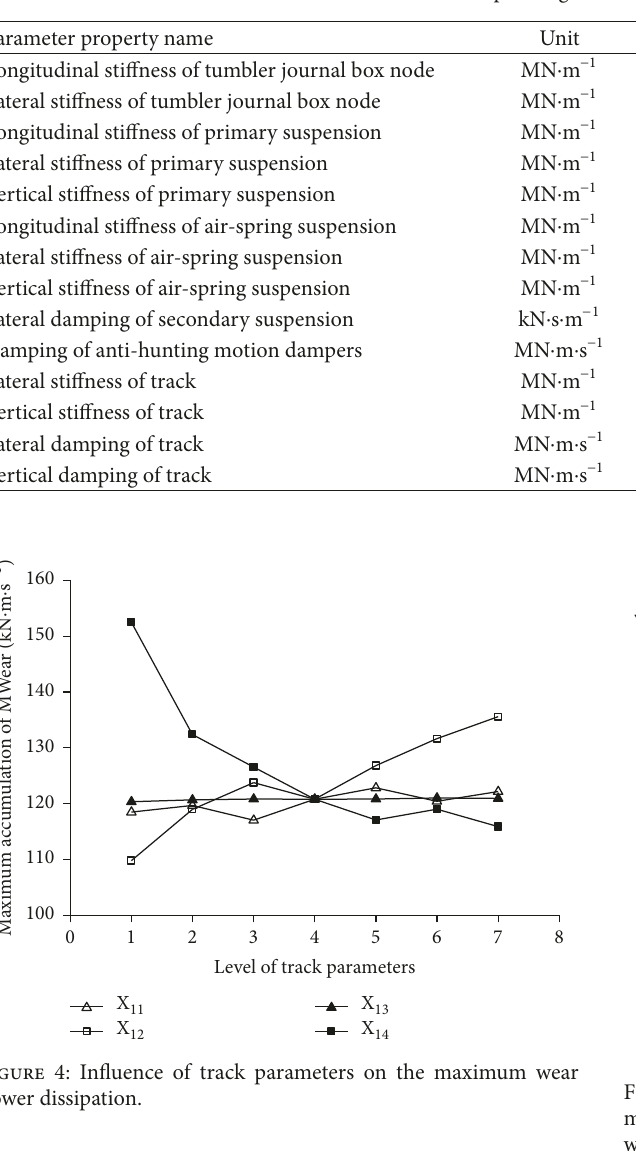
Table 3: Corresponding sensitivity factor of each factor.